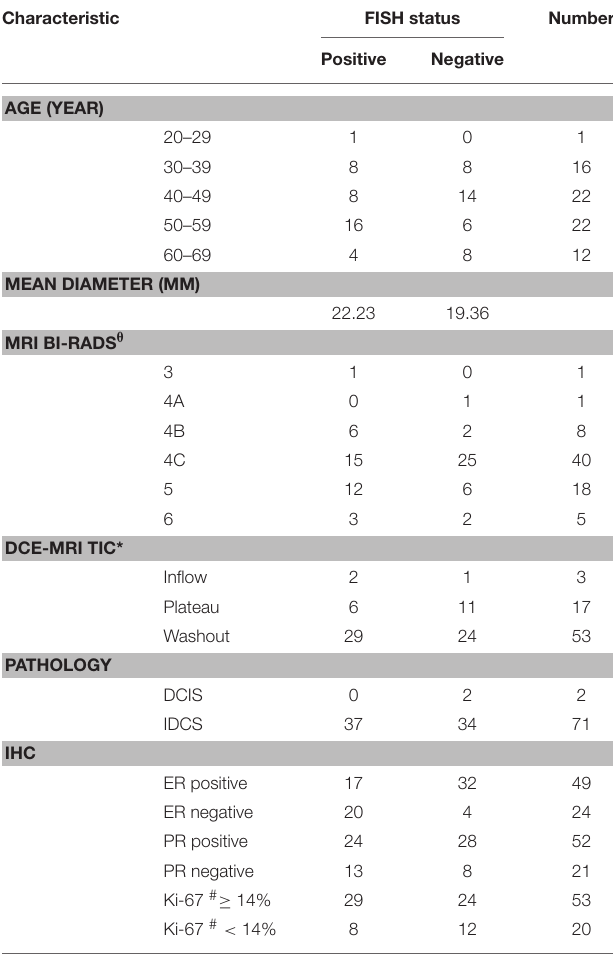
TABLE 1 | Details of selected cases with HER2 2 + status confirmed by FISH.